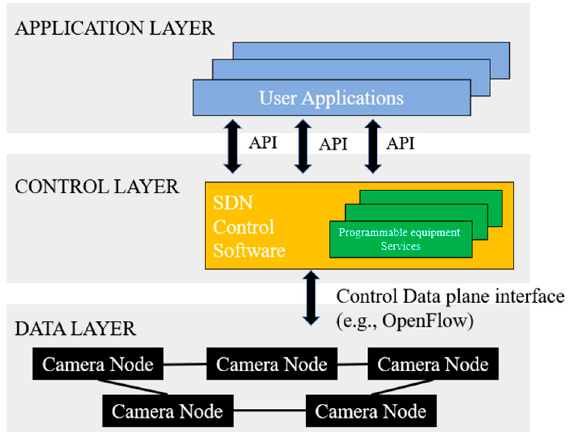
Figure 1. The structure of SDN-assisted wild animal information collection system.